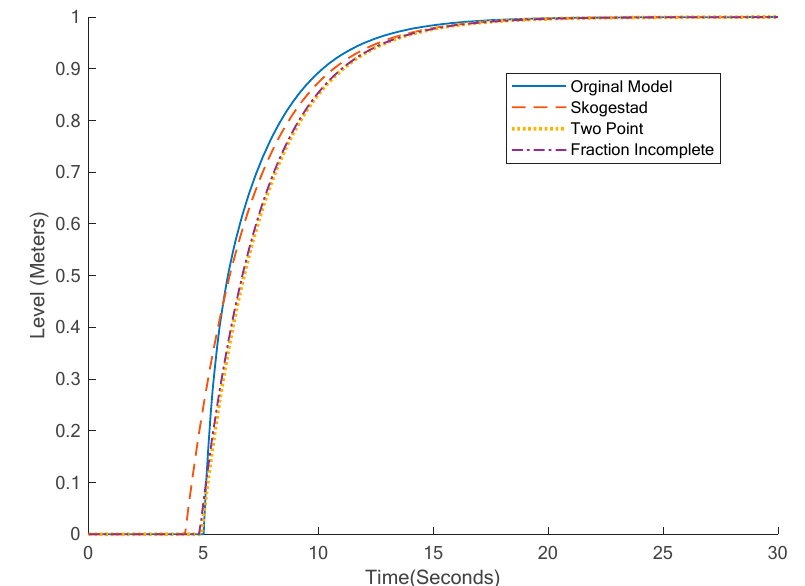
Figure 8. Open-loop step response with reduced models.